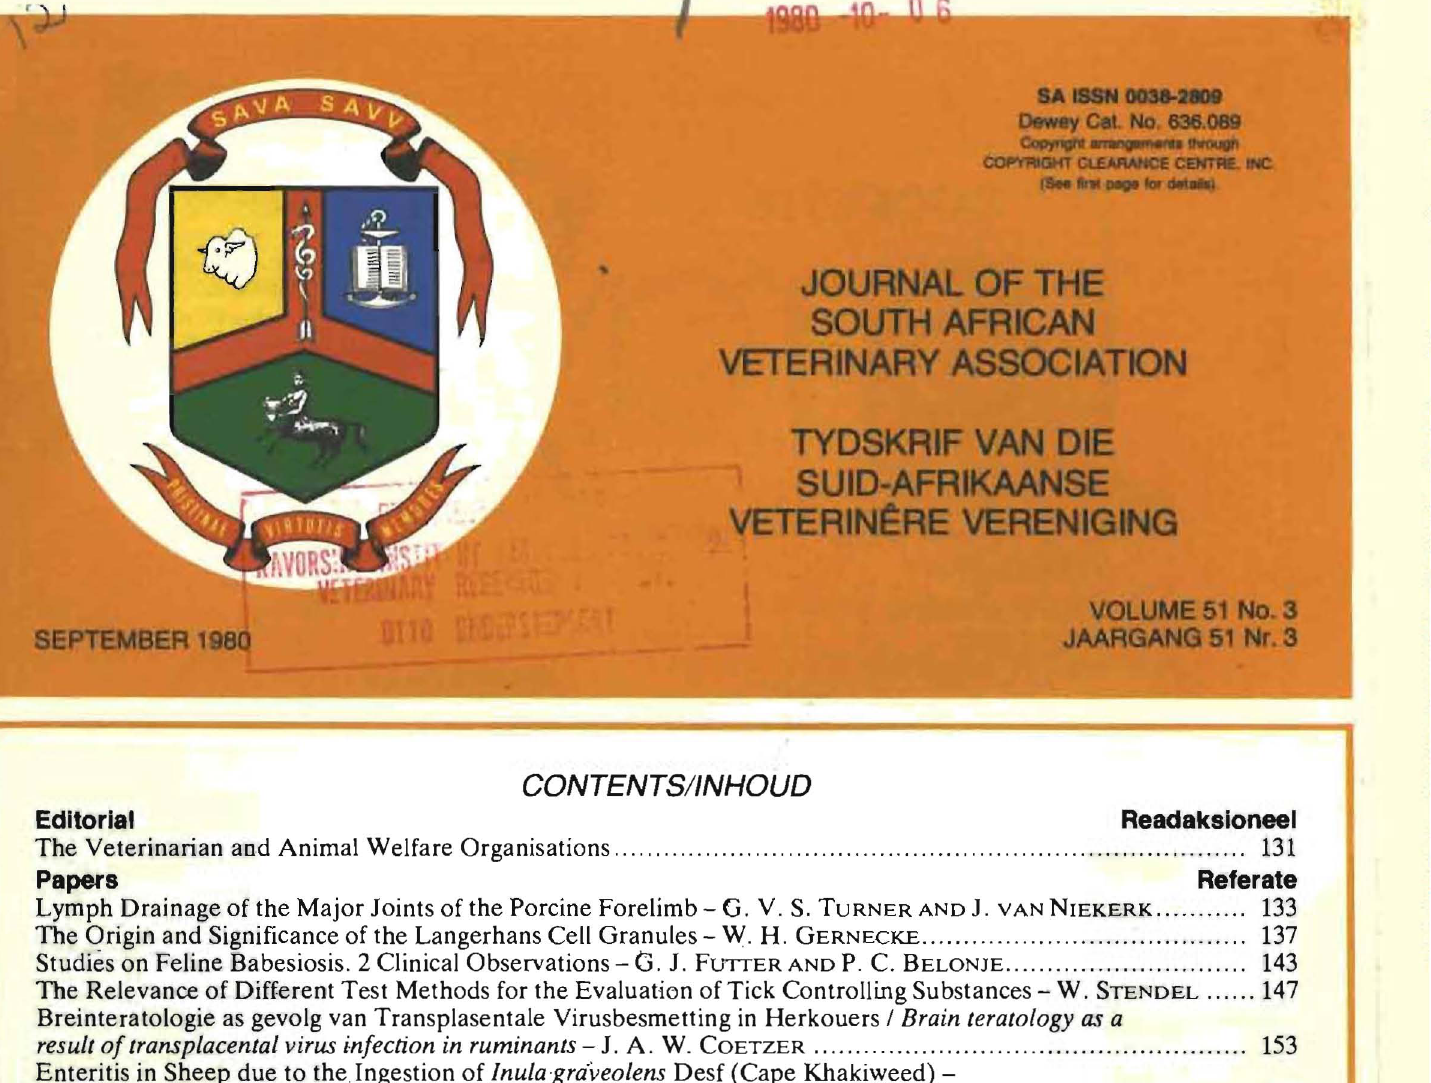
Lymph Drainage of the Major Joints of the Porcine Forelimb - G. V. S. TURNER AND] . VAN NIEKERK ........... 133 The Origin and Significance of the Langerhans Cell Granules - W. H. GERNECKE .................. .. ...................